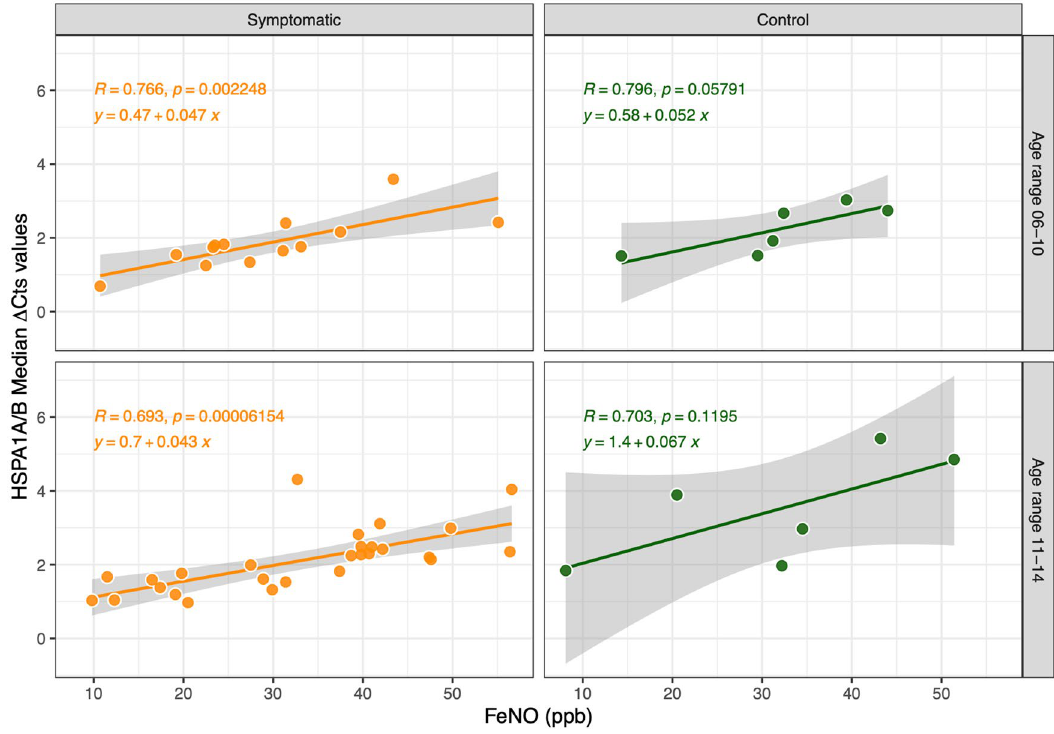
Figure 3. Regression and correlation between FeNO concentration and ∆Cts of HSPA1A/B in AR subjects and control group, separated into two age ranges.